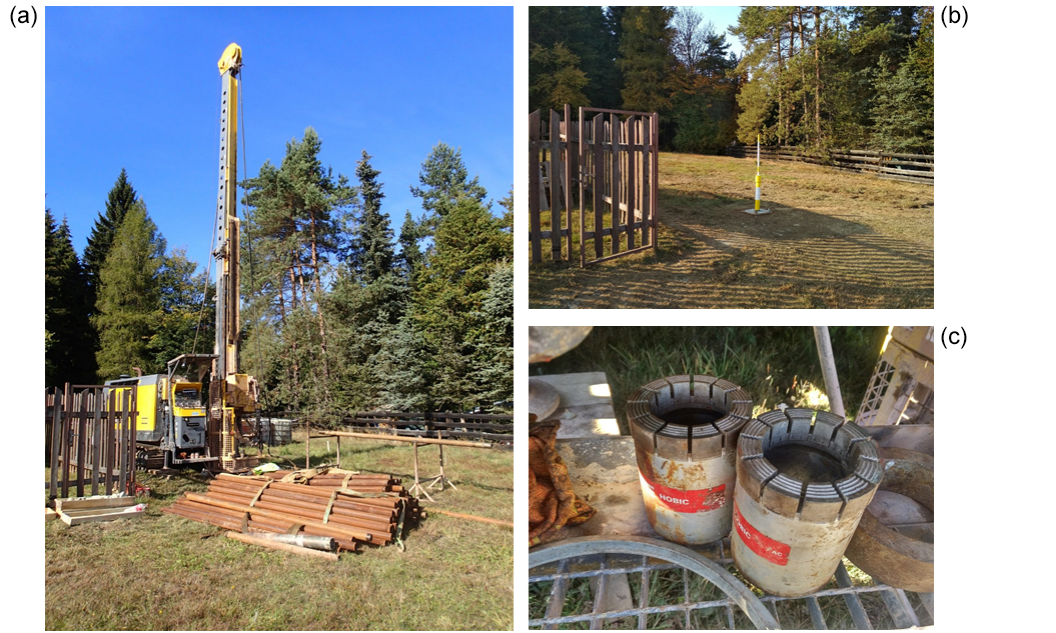
Figure 3. The Eger Rift drilling setup, showing (a) the drilling rig with drilling rods at the S3 site, (b) the wellhead after the termination of work at the S3 site and (c) an example of a diamond drill head designed for drilling in hard rocks.